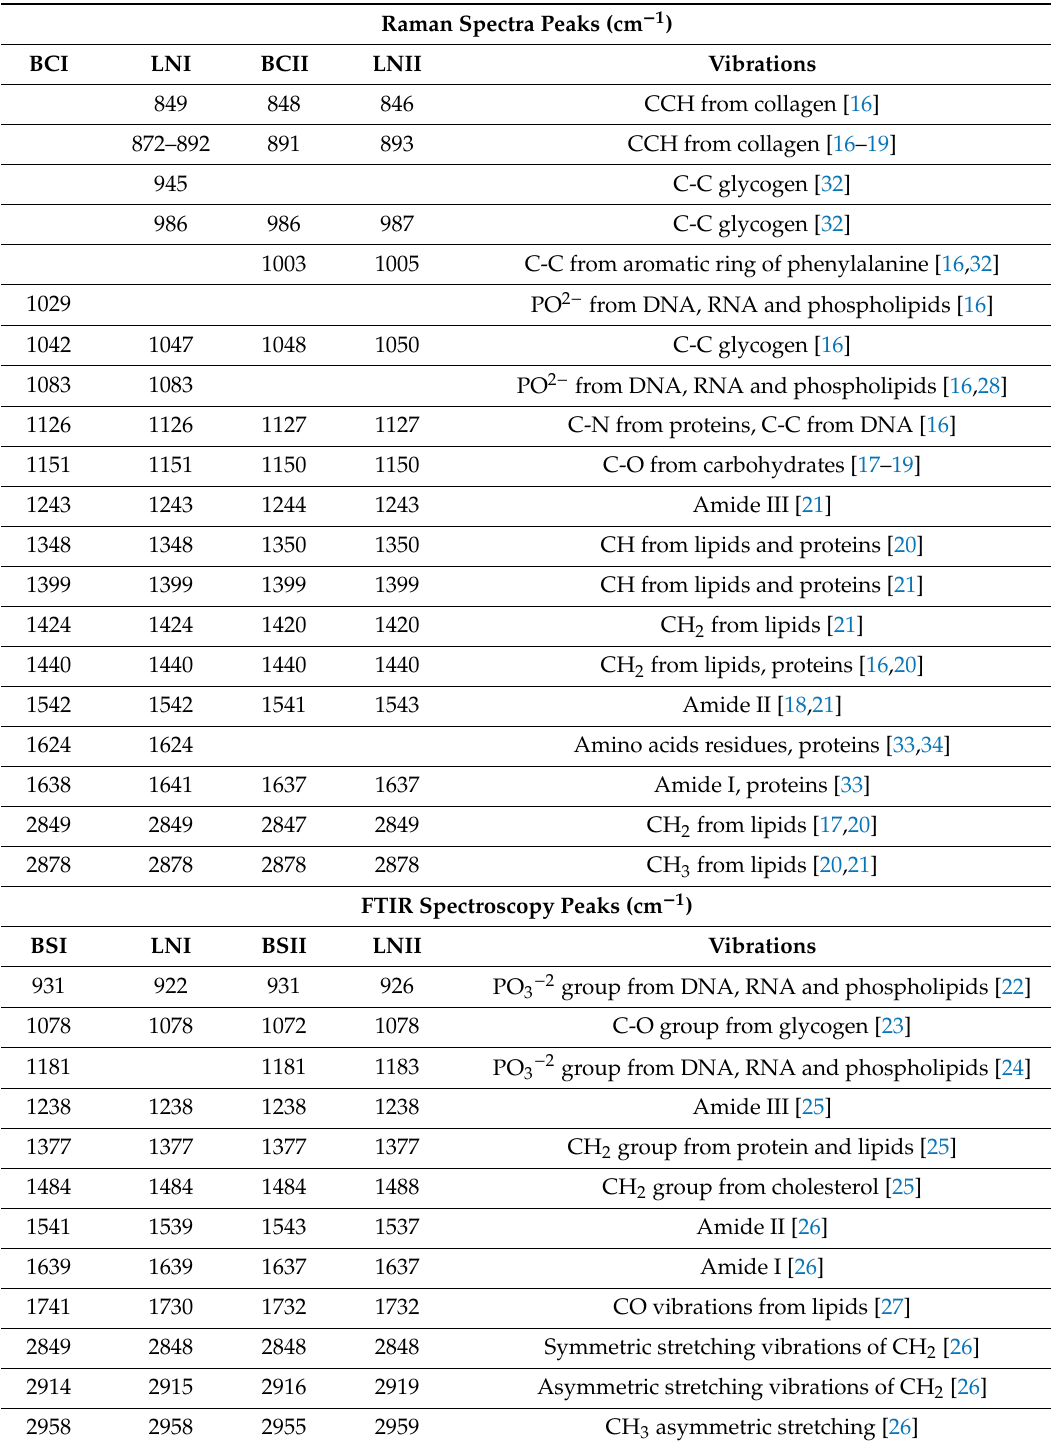
Table 1. Wavenumbers of the Raman and FTIR peak positions with corresponding vibrations in analyzed samples, where BCI and LNI mean the breast cancer tissues and LNs obtained from the I group, while BCII and LNII mean the breast cancer tissues and LNs obtained from the II group